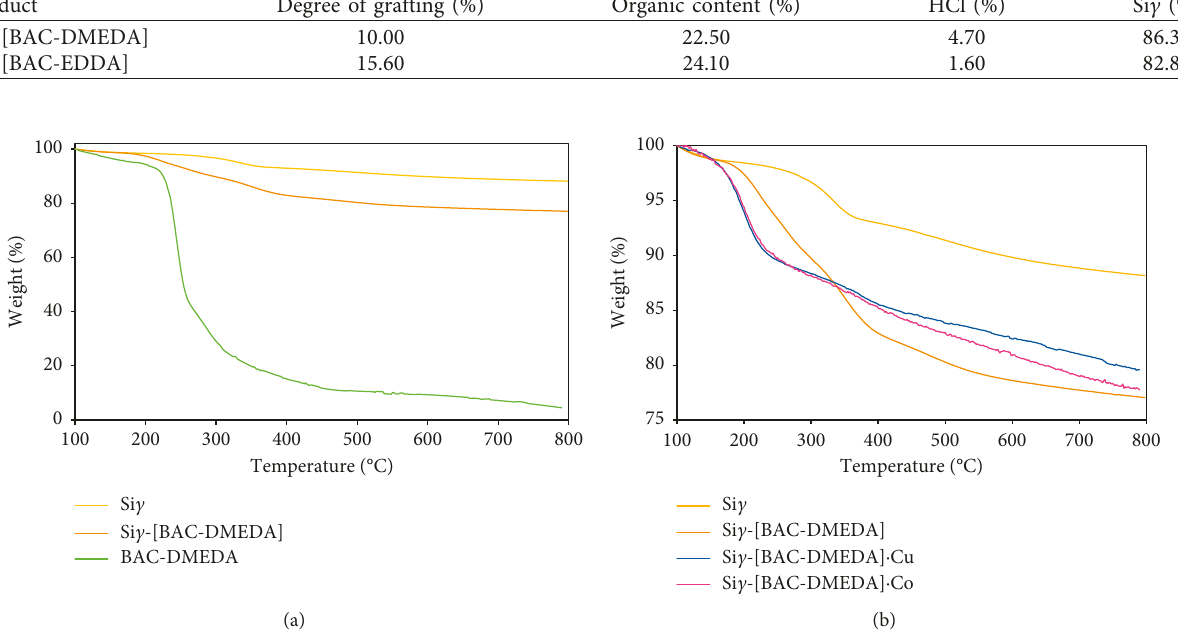
Table 2: Degree of grafting evaluated by calcinations and confirmed by elemental analyses. Product